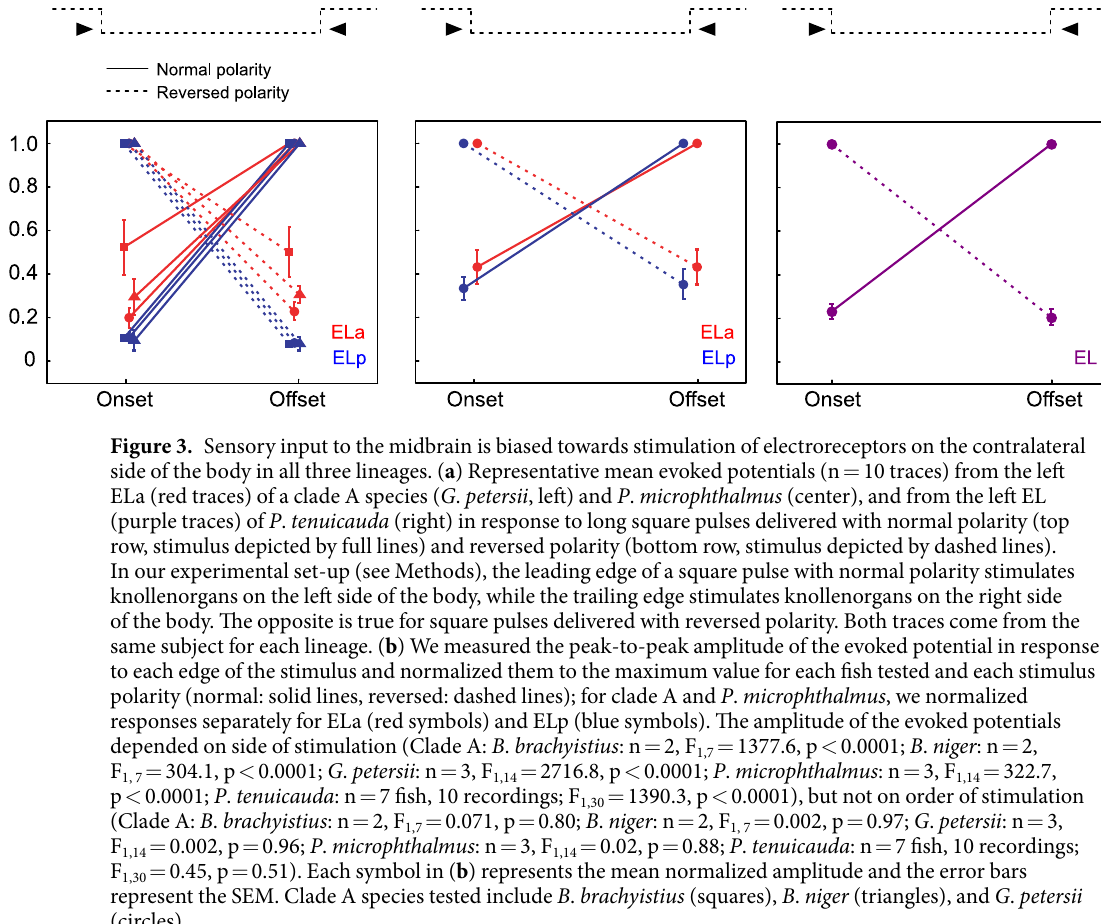
5 Scientific RepoRts | 7: 3783 | DOI:10.1038/s41598-017-03951-y